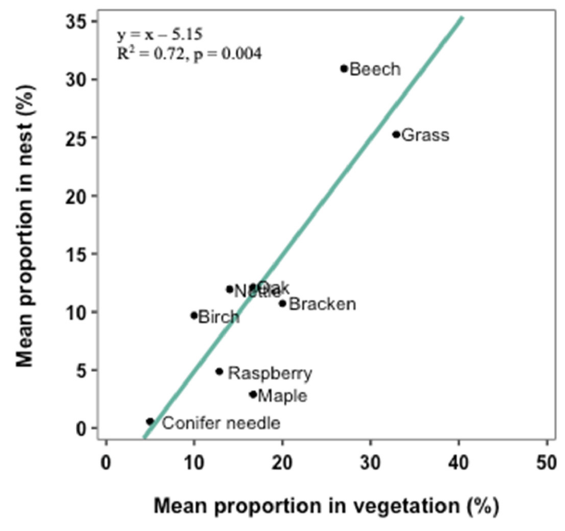
Figure 3. Relationship between availability of nine plant materials and their use in hazel dormouse summer nests. These plant materials are beech, grass, oak, nettle, bracken, birch, raspberry, maple, and conifer needle. The proportion of material in nests is plotted against the proportion of material in the vegetation within 5 m of the nest box. A linear green tendency line is plotted as well with the equation y = 1x − 5.15 and a fit of R 2 = 0.72.